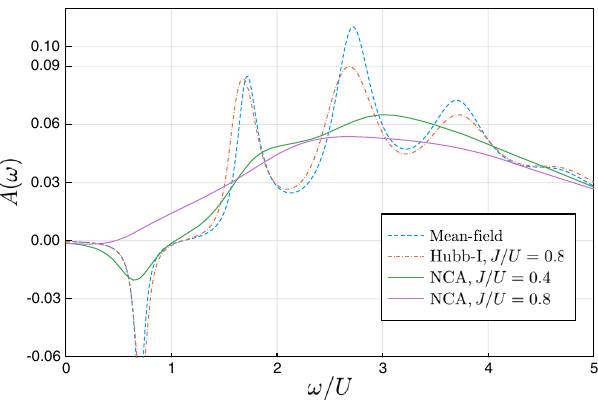
FIG. 7. Local spectral function A ð ω Þ for different values of J=U , as computed within Gutzwiller mean-field theory (dashed blue line), DMFT with Hubbard-I impurity solver (dashed red line), and NCA impurity solver (green and pink full lines), for fixed z ¼ 6 and r ¼ 2 . Within NCA, we see that